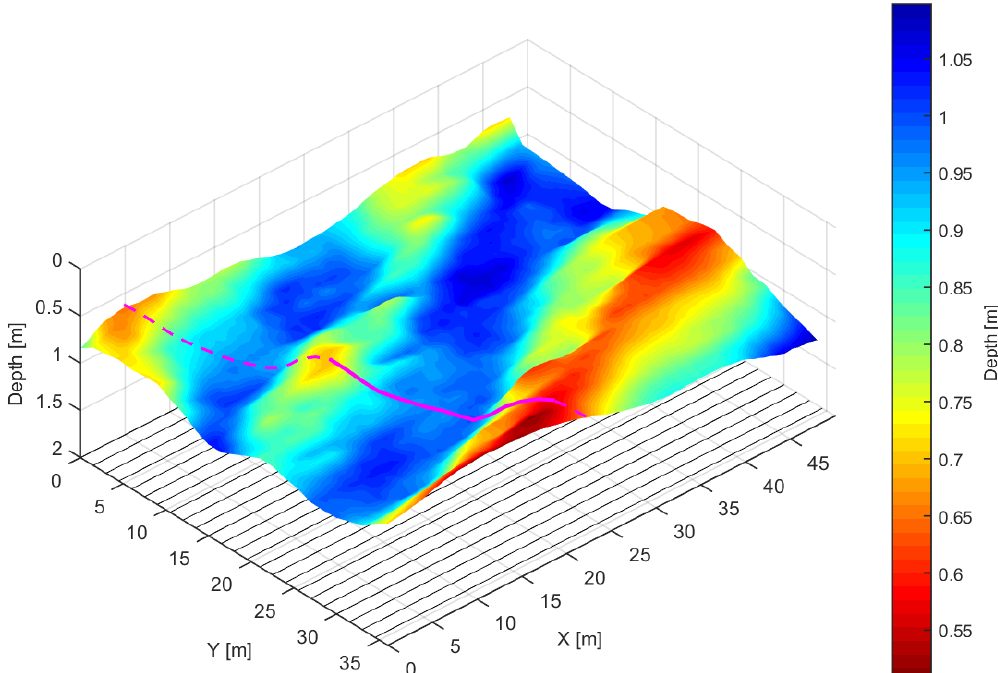
Figure 2. The underlying interface of soil architecture derived from GPR measurements (adapted from Pan et al., 2012) and the selected transect (magenta curve along the dashed cutting line) perpendicular to the longitudinal troughs. The bottom lines are a projection of the 25 GPR survey